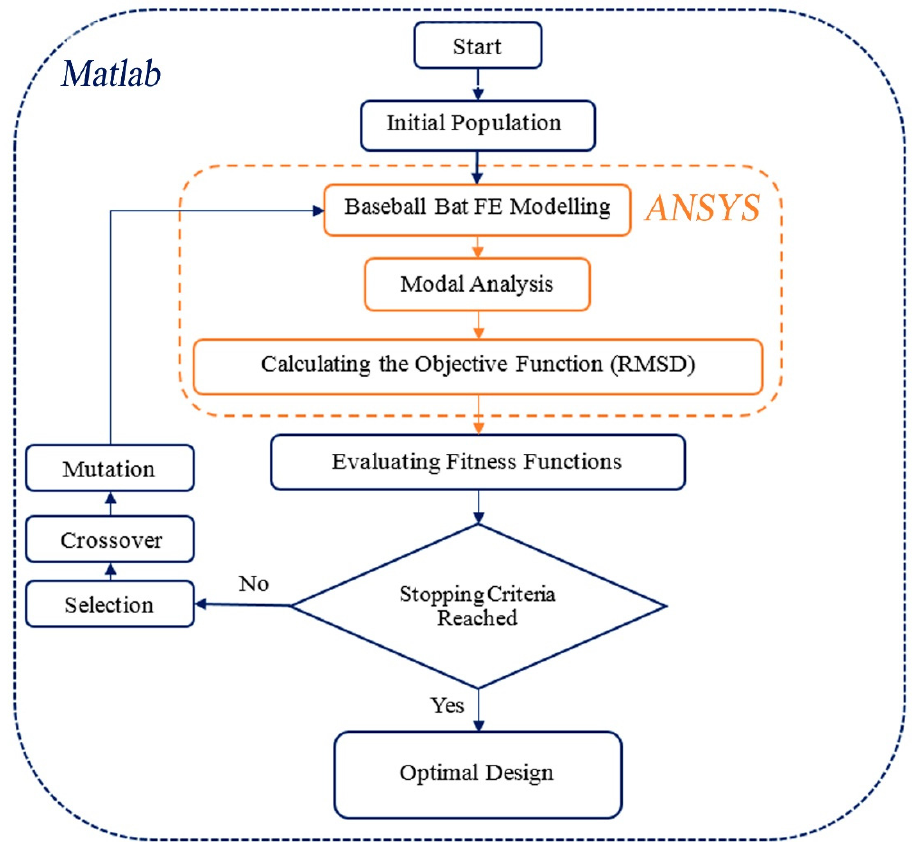
Figure 6. The optimization process flowchart.